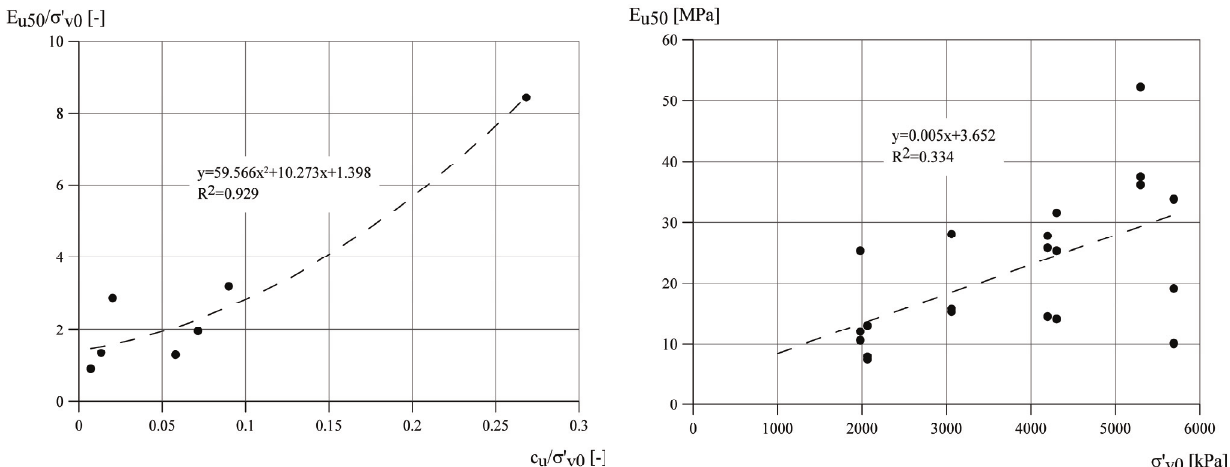
Fig. 2. Normalized undrained modulus E u 50 versus normalized undrained shear strength c u